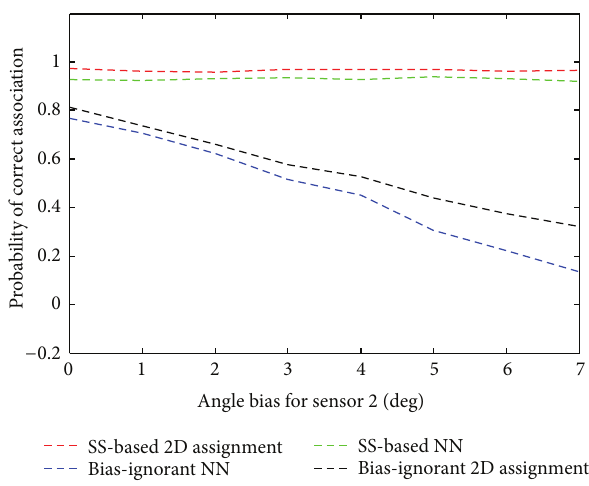
Figure 8: Average probability of correct association via different angle biases.